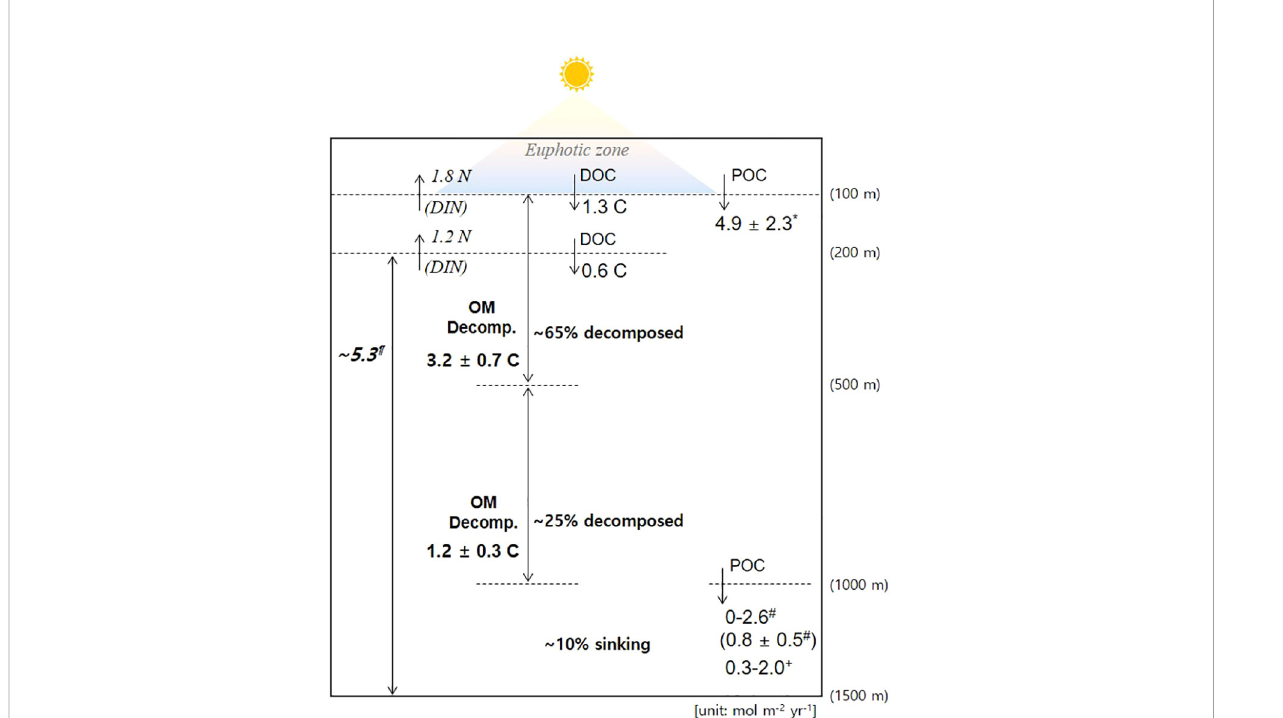
FIGURE 5 A schematic of the vertical fl uxes of dissolved inorganic nitrogen (DIN) and organic carbon in the upper East Sea. The vertical fl uxes of DIN and dissolved organic carbon (DOC) are based on the DIN and DOC gradients and the estimated eddy diffusivity. OM Decomp. denotes the decomposition rate of organic matter/carbon, which is estimated based on the Ra-age-based oxygen utilization rates (OUR). The downward fl uxes of particulate organic carbon (POC) are from previous studies: # Sediment trap (at 1000 m, Kim et al., 2020), + Sediment trap (at 1000 m, Kwak et al., 2017), *234Th method (Kim et al., 2011), and ¶ carbon export production using 3 H and 3 He tracers (Kim and Hahm,